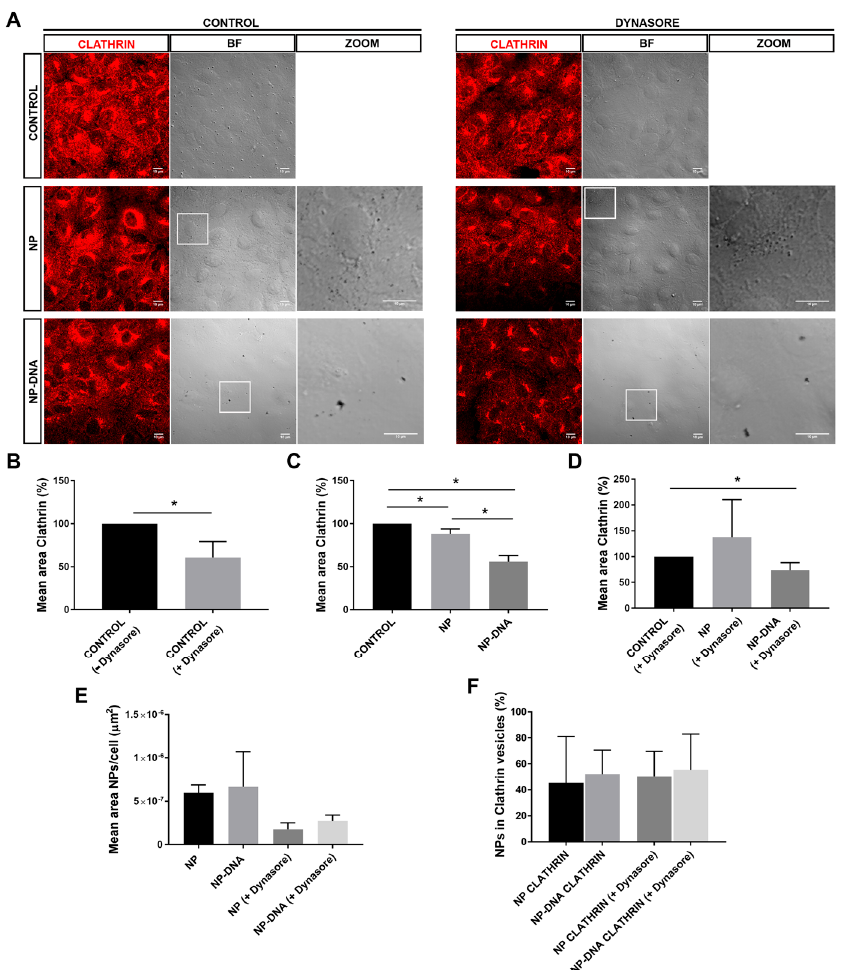
Figure 2. DNA-gold nanoparticles are uptaken by differentiated ARPE-19 cells through different vesicular and/or non-vesicular routes. ( A ) After 2 h post-transfection, between 40 and 60% of pristine gold NPs and DNA-wrapped gold NPs are detected in clathrin-coated vesicles. NPs are visualized as black dots in the optic transmission microscopy channel (BF-bright field, see also zoom panels). DNA nanoparticles appear in clusters compared to pristine 40 nm gold particles. Clathrin-coated vesicles are immunodetected in red. Dynasore treatment inhibited the uptake by dynamin-mediated events. Image analyses of colocalization were performed by using masks over different channels. ( B ) Treatment with dynasore reduced down to 60% the number of clathrin-coated vesicles in untransfected cells, after 2 h. Addition of DNA nanoparticles in either ( C ) control conditions or ( D ) with dynasore treatment significantly reduced down to 55% the number of clathrin-coated particles. ( E ) At 2 h post-transfection, the mean area of NPs/cell uptaken by differentiated RPE is reduced two-fold in dynasore-treated cells, reflecting that at least half of the nanoparticles are internalized by dynamin-mediated events; remarkably, the mean area of internal NPs is higher in cells transfected by DNA-wrapped NPs compared to pristine NPs. ( F ) Percentage of NPs/cell in clathrin-coated vesicles is highly similar in all conditions, ranging between 40 and 50%, indicating that a large pool of NPs was not uptaken by RPE cells using this route. Representative images from three independent replicates (three images per replicate and condition) were quantified. Statistical significance was analysed by the non-parametric Mann–Whitney test (*indicates p < 0.05).